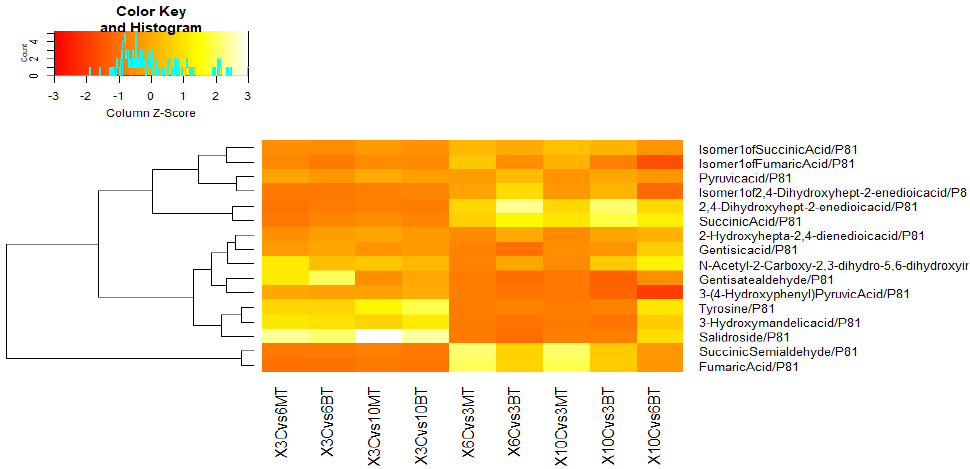
Figure 7. Heat map showing some of the differentially expressed metabolites of Alanine, Aspartate, and Glutamate metabolism (P1) and Arginine and Proline metabolism (P5) pathways in different comparisons between positive control plants (C) and Metarhizium (MT) or Beauveria (BT) treatments at different Dpi. Z score is a measure of distance, in standard deviations, from the plate mean. A well with a Z score of 0 has the same raw value as the plate mean. A well with a Z score of 1.0 is exactly one standard deviation above the plate mean and a Z score of −0.5 is half a standard deviation below the plate mean.